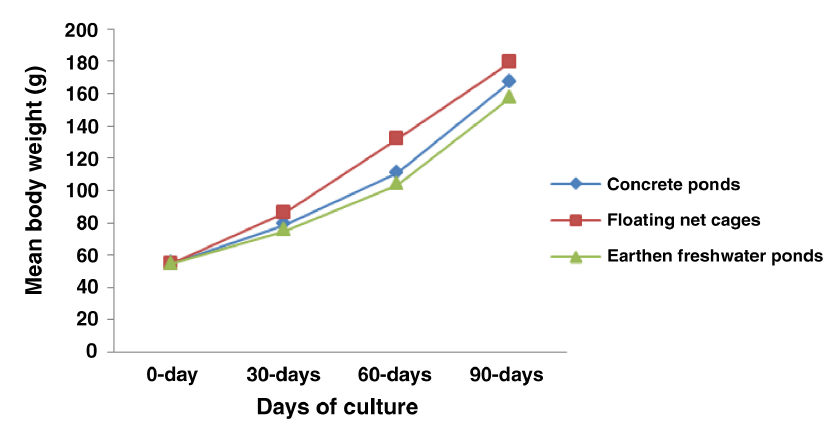
Figure 1. Mean weight gain ± SD (g) of gurami sago in three different aquaculture systems.